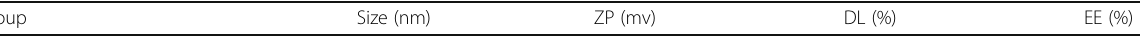
Table 1 The physiochemical properties of different micelles ( n = 3) Group Size (nm) Pp IX-loaded LH